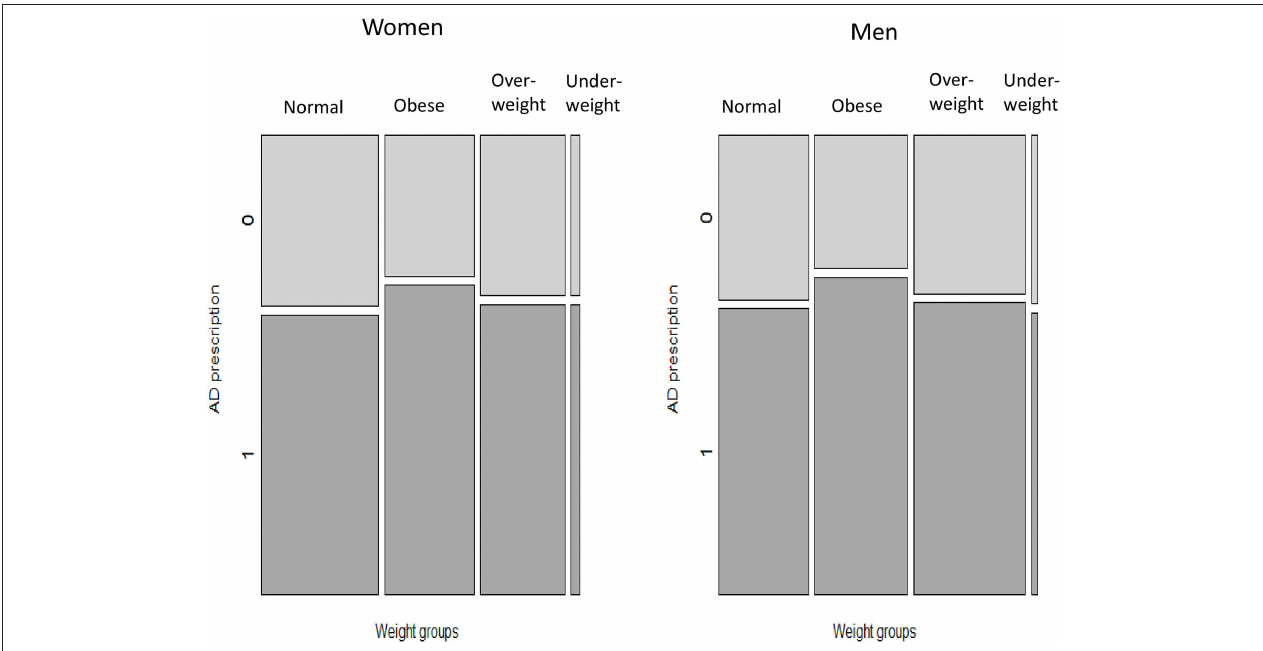
FIGURE 2 | Prevalence of AD prescribing among patients of different weight categories, according to sex. AD, antidepressant medications. The bars (Normal, Obese, Overweight, Underweight) represent weight categories; thickness of the bars represent a proportion of patients in each weight category. Dark tiles represent proportions of patients with AD prescriptions (“1”), light tiles—proportions of patients without AD prescriptions (“0”) in each weight